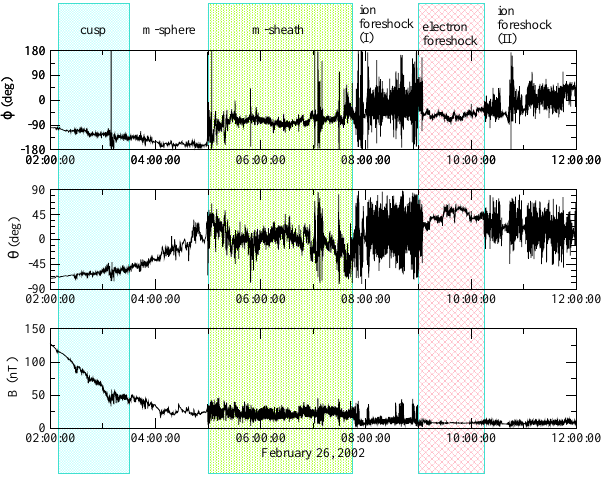
Fig. 4. Sketch of a typical longitude latitude representation of the array power. The direction to the Sun is in the center of the map. A set of parallel and meridian lines associated with the magnetic field direction is shown for reference. The magnetic field line going through the wave source follows a meridian line. The directions making the same angle with the magnetic field as the detected wave gather along a parallel